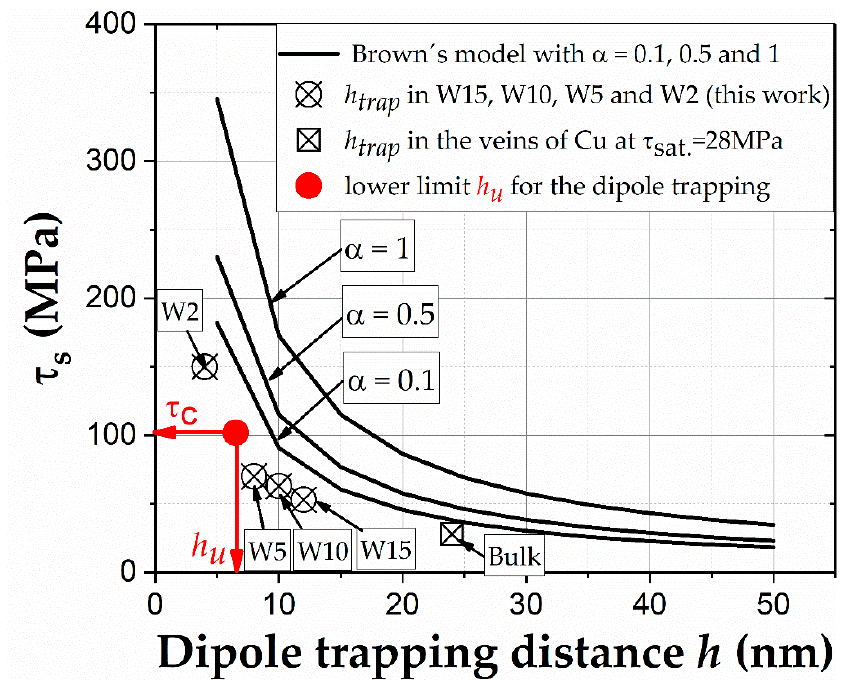
Figure 9. Graphical overview of the dipole trapping distance h of the microsamples 15, 10, 5, and 2 µ m (W15, W10, W5, W2) calculated using Neumann’s Equation (5), the mean h of edge dislocation dipole in veins of Cu bulk single crystals, as well as the lowest critical dipole trapping distance h u with the corresponding maximal critical τ c . Additionally, based on Brown´s criterium (Equation (4) with α = 0.1, 0.5, and 1) the change of the trapping distance h for screw dislocations is also illustrated as reference.